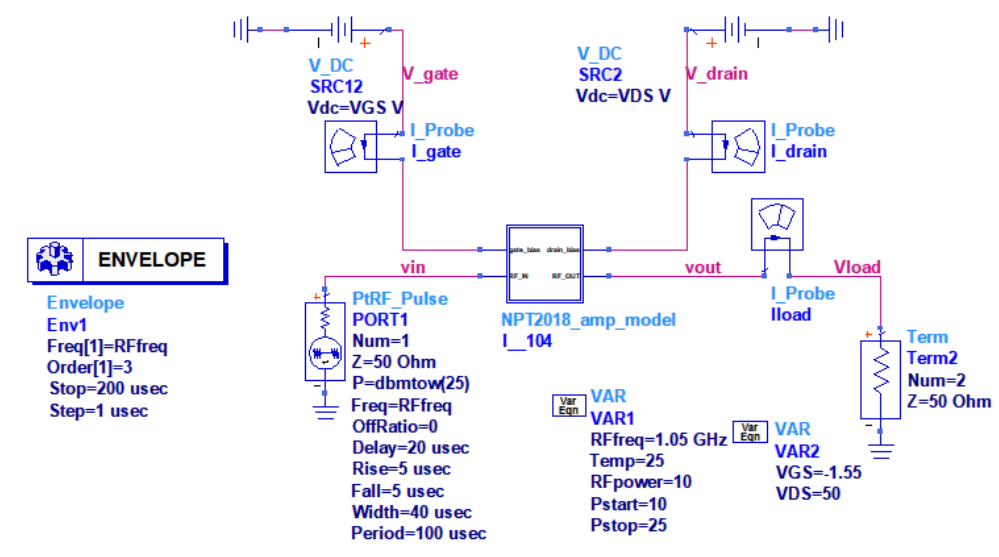
Figure 9. S imulation ADS schematic for modeling of PA transmittance. Figure 9. Simulation ADS schematic for modeling of PA transmittance.